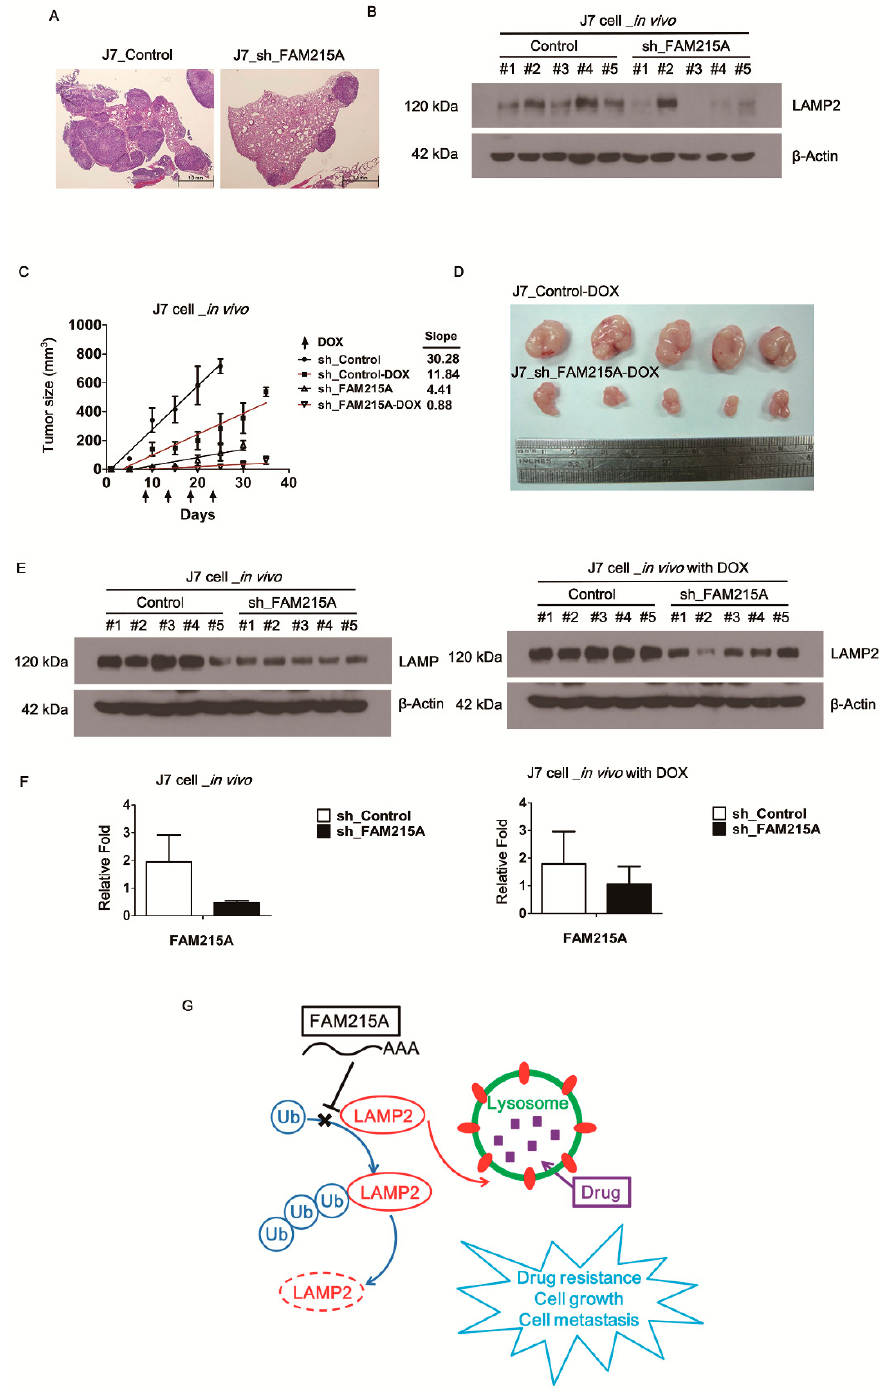
Figure 6. FAM215A promotes tumor progression and drug resistance in vivo by xenograft mouse. ( A ) Injection of the FAM215A knockdown in J7 cells by tail vein in severe combined immunodeficiency (SCID) mice (n = 5). The hematoxylin and eosin (H&E) staining of the tumor in lung tissues was used to determine the metastasis capacity. ( B ) LAMP2 expression from the tumor in the lung by Western blot. ( C , D ) A ff ect FAM215A on the tumor growth curve (slope) and drug resistance capacity treated with Doxroubicin (4 mg / kg). FAM215A depleted in J7 cells were subcutaneously injected into nude mice (n = 5). ( E,F ) Expression of the LAMP2 and FAM215A determined by Western blot or qRT-PCR. β -Actin and 18s rRNA were used as the loading controls. Arrow indicates the time of Doxroubicin treatment. Data are presented as means ± SD of five independent experiments. ( G ) Diagram of FAM215A inhibits LAMP2-ubiquitination to confer drug-resistant in